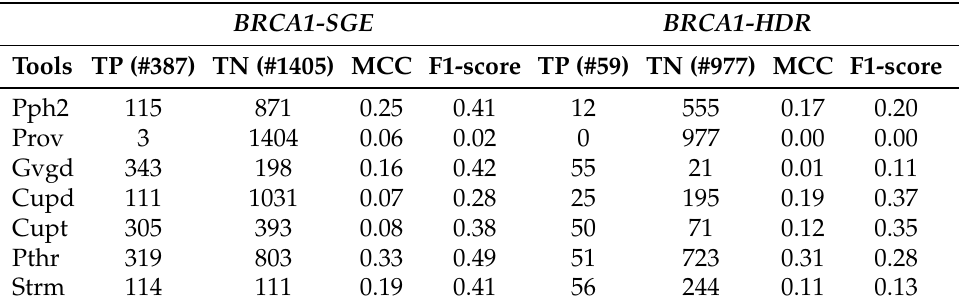
Table 4. The outer consistency of